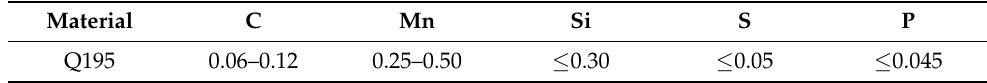
Table 1. Chemical composition (wt.%) and mechanical properties of Q195 steel.